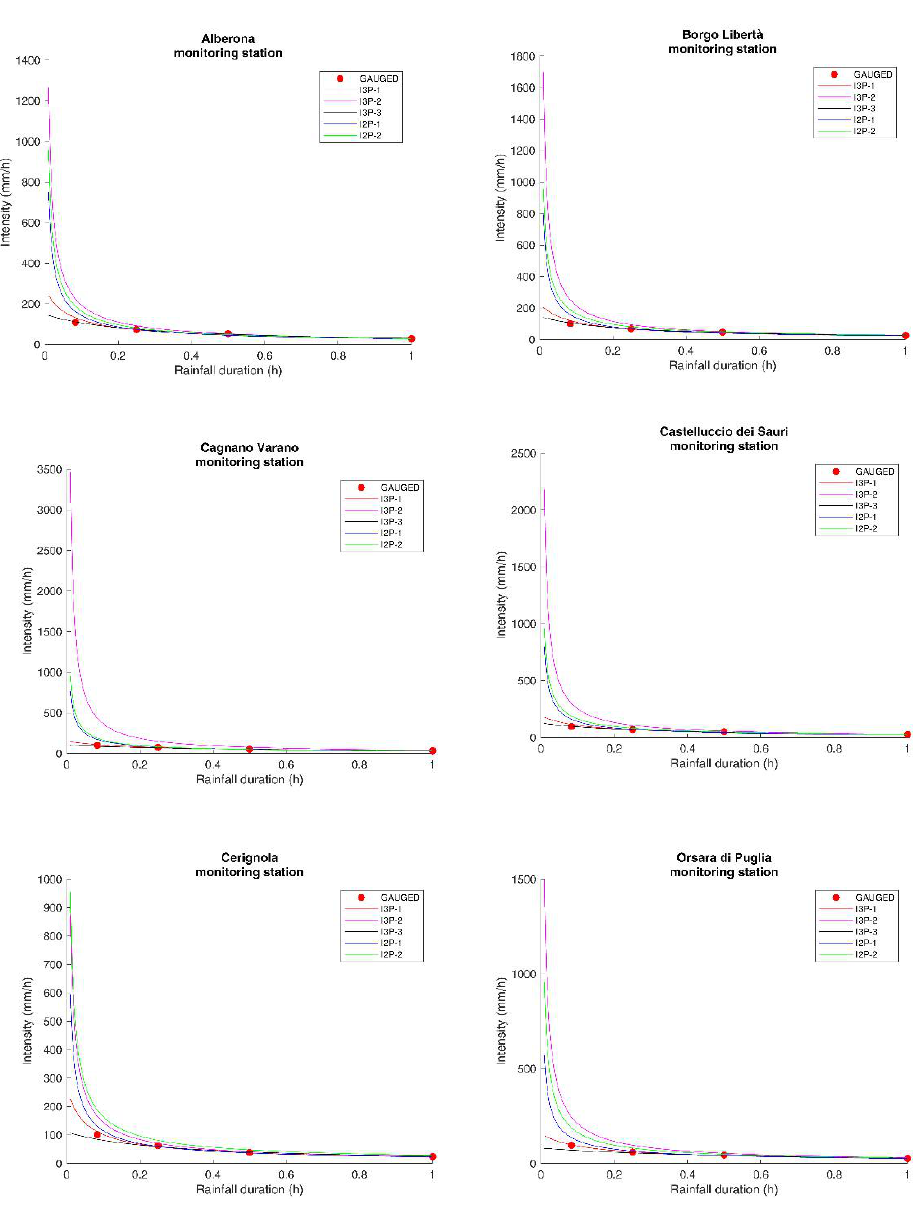
Figure 3. IDF curves for short durations4.1. Results of DDFs Error Measures